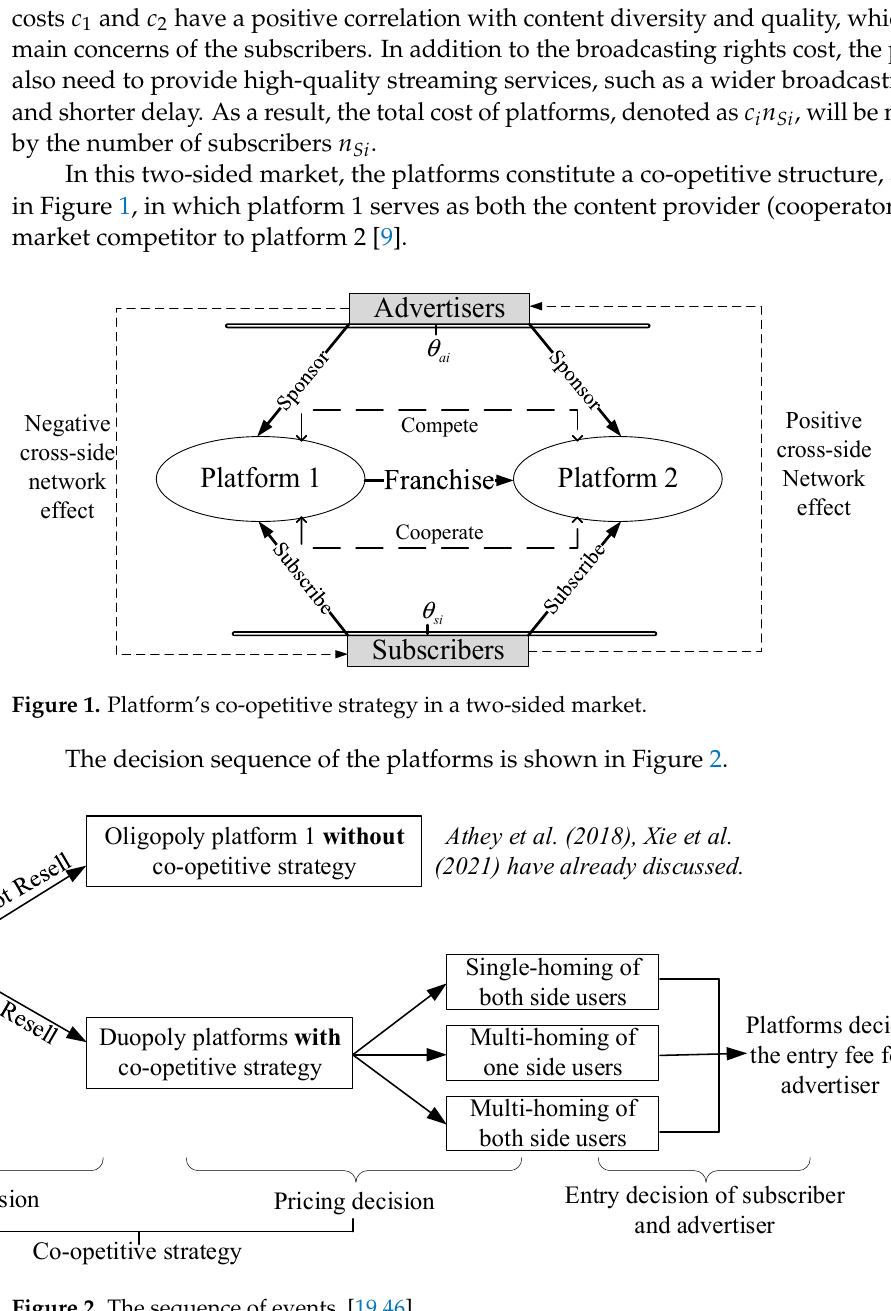
Figure 2. The sequence of events. [19,46]